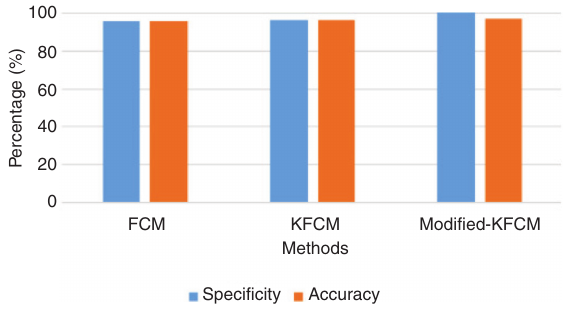
Figure 10: Graphical comparison of accuracy and specificity.